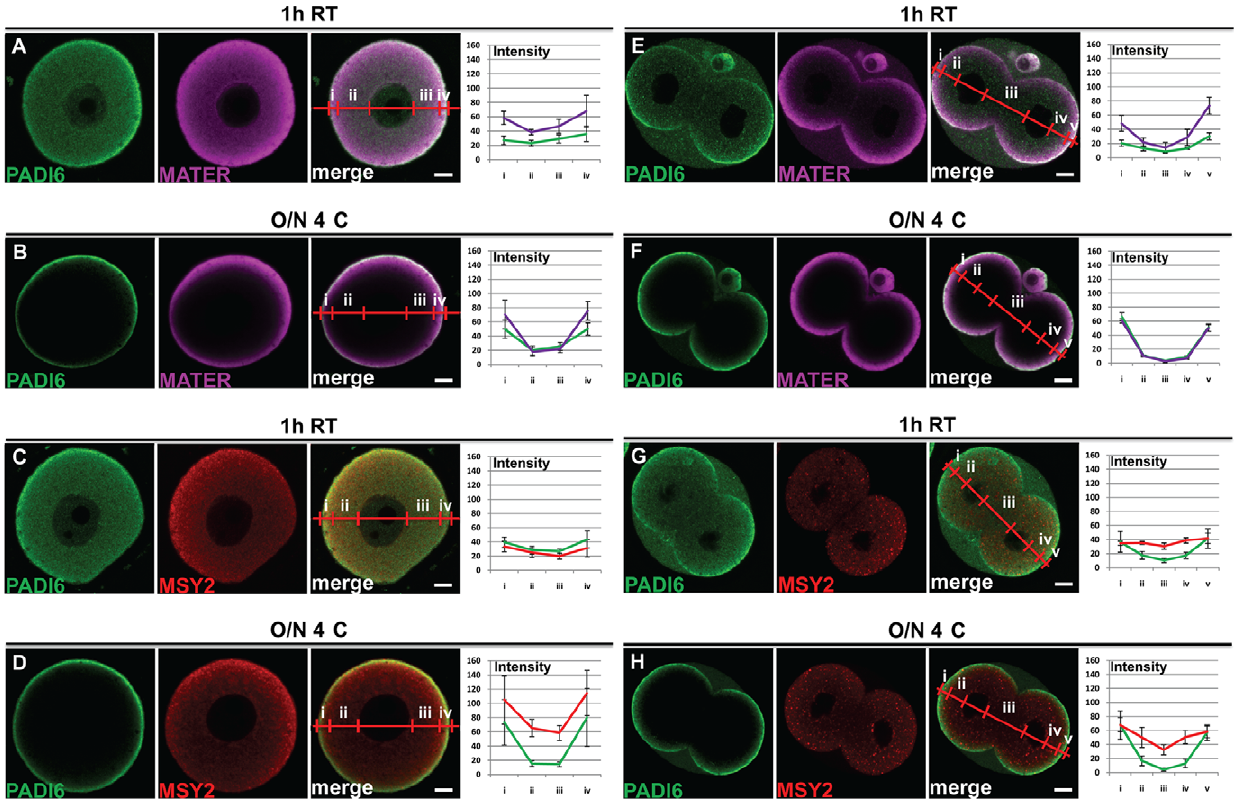
Figure 1. Time and temperature influence the staining pattern of PADI6 and MATER, but not MSY2. GV oocytes (A-D) and two-cell embryos (E-H) were prepared for IF and stained with antibodies against PADI6 (A-H), MATER (A, B, E and F) or MSY2 (C, D, G and H). Primary antibody incubation was carried out at either 1 h RT (A, C, E and G) or O/N 4 u C (B, D, F and H). PADI6 is shown in green, MATER in magenta and MSY2 in red. Included are graphs of the averages and standard deviations of four intensity profiles of four images per condition of the different stains in either cortical (i and iv) or cytosolic (ii and iii) zones for the oocytes or cortical (i and v), basolateral cytosolic (iii) or apical cytosolic (ii and iv) zones for the embryos. Bars, 10 m m.